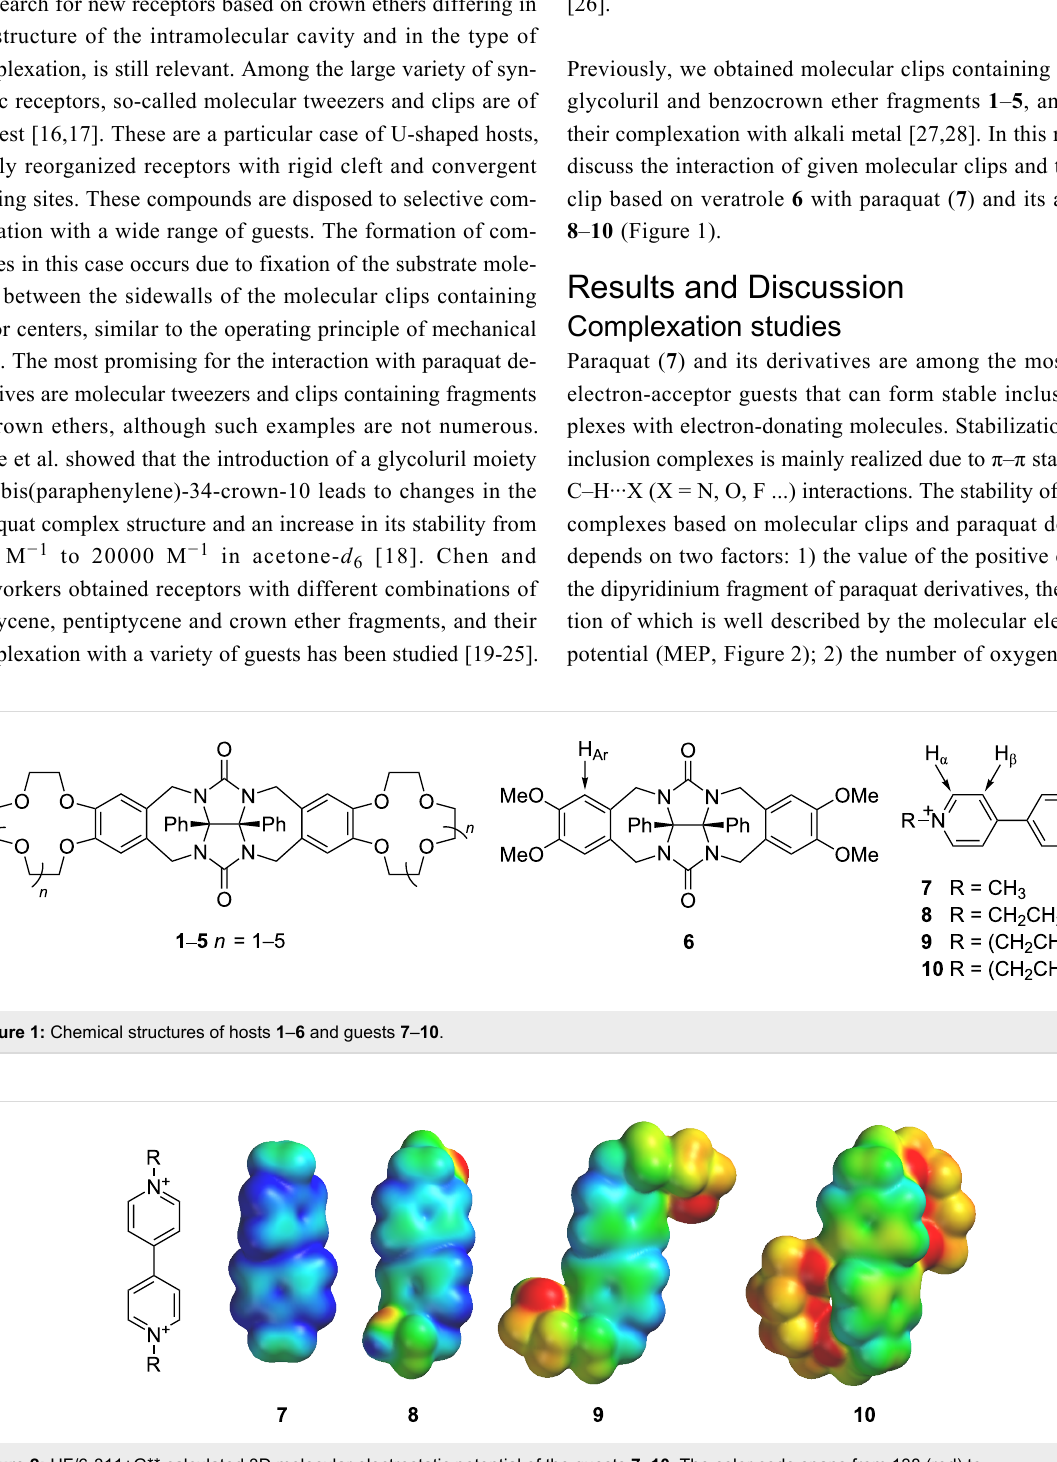
Figure 2: HF/6-311+G** calculated 3D molecular electrostatic potential of the guests 7 – 10 . The color code spans from 138 (red) to 177 kcal/mol